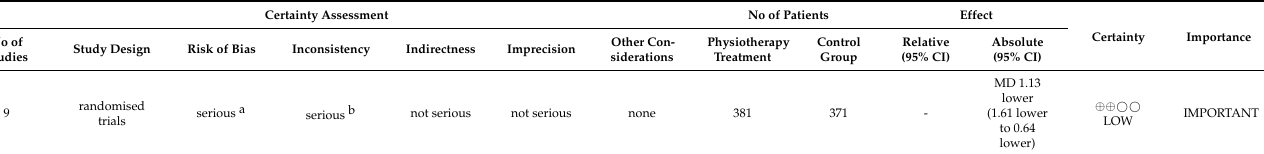
Table 5. Grading of Recommendations Assessment, Development and Evaluation (GRADE) evidence